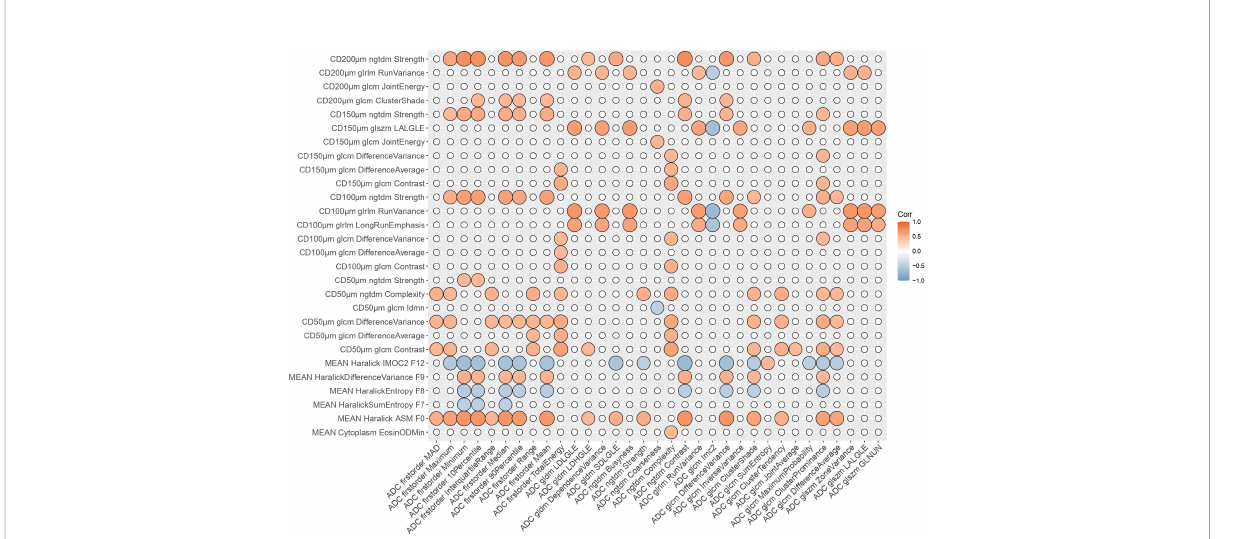
FIGURE 2 Radiopathomic analysis between ADC radiomic features and pathomic features. Correlation matrix fi ltered from nonsigni fi cant correlations (rows and columns with non signi fi cant values were deleted, while nonsigni fi cant values surviving were set to zero). CD, Cellular Density; ADC, Apparent Diffusion Coef fi cient; LALGLE, Large Area Low Gray Level Emphasis; IMOC, Information Measure Of Correlation; ASM, Angular Second Moment; LDLGLE, Large Dependence Low Gray Level Emphasis; LDHGLE, Large Dependence High Gray Level Emphasis; SDLGLE, Small Dependence Low Gray Level Emphasis; LALGLE, Large Area Low Gray Level Emphasis; GLNUN, Gray level non uniformity normalized; glcm, gray level co-occurrence matrix; gldm, Gray Level Dependence Matrix; glszm, Gray Level Size Zone Matrix; ngtdm, Neighbouring Gray Tone Difference Matrix; glrlm, Gray Level Run Length